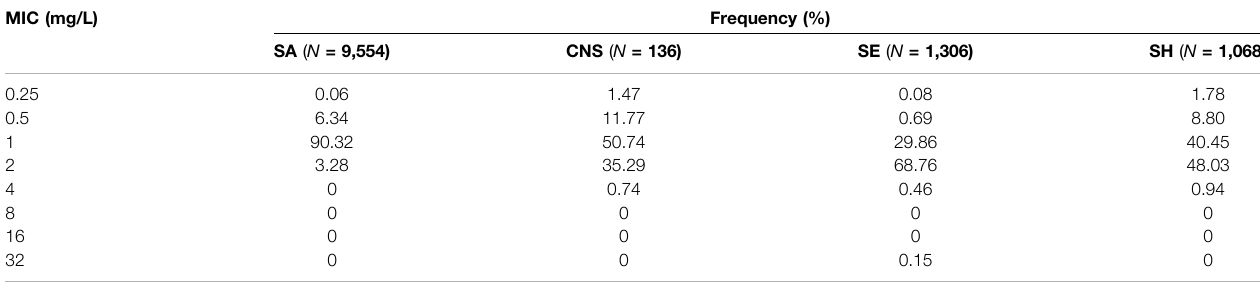
TABLE 1 | Frequency distributions of MIC for simulated pathogens. MIC (mg/L) Frequency (%)